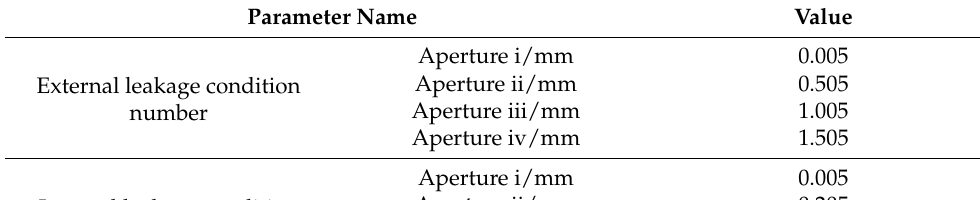
Table 9. Actuator external leakage and internal leakage under different working conditions.